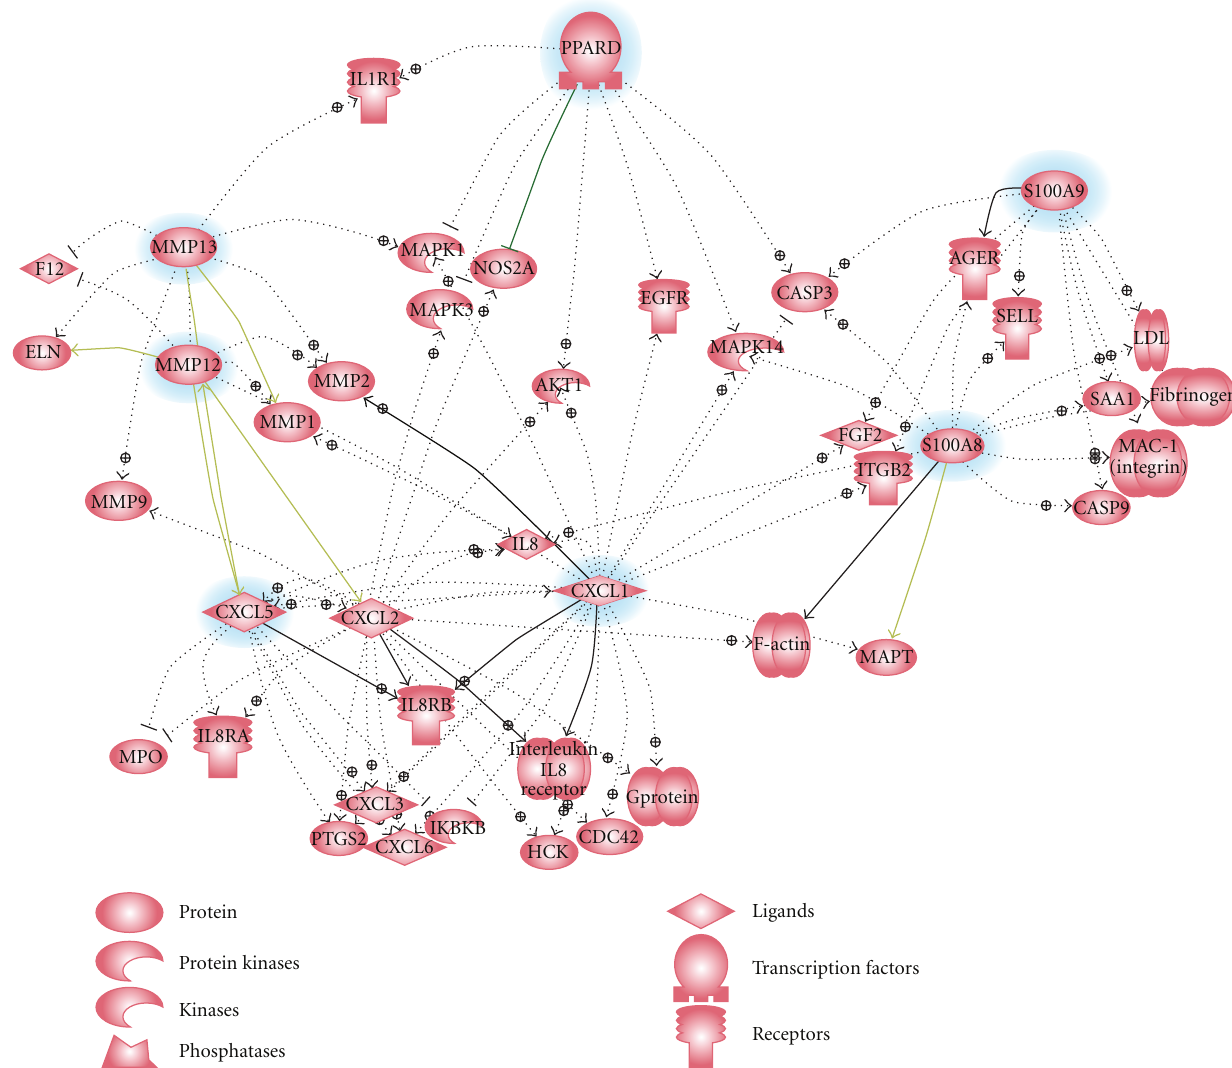
Figure 5: Signaling networks associated with PPAR δ and inflammatory and invasive gene expression. Common signaling pathways were analyzed for six genes with the greatest changes in expression in gastric tumors (highlighted in blue ) versus forestomach using Ariadne Pathway Studio